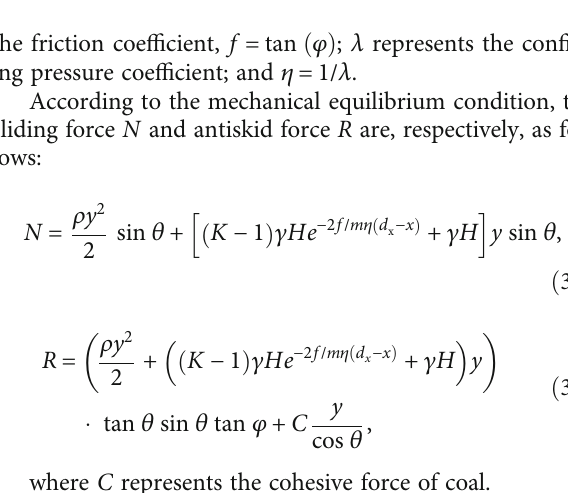
Figure 9: Layout diagram of retracement channel and fi lling